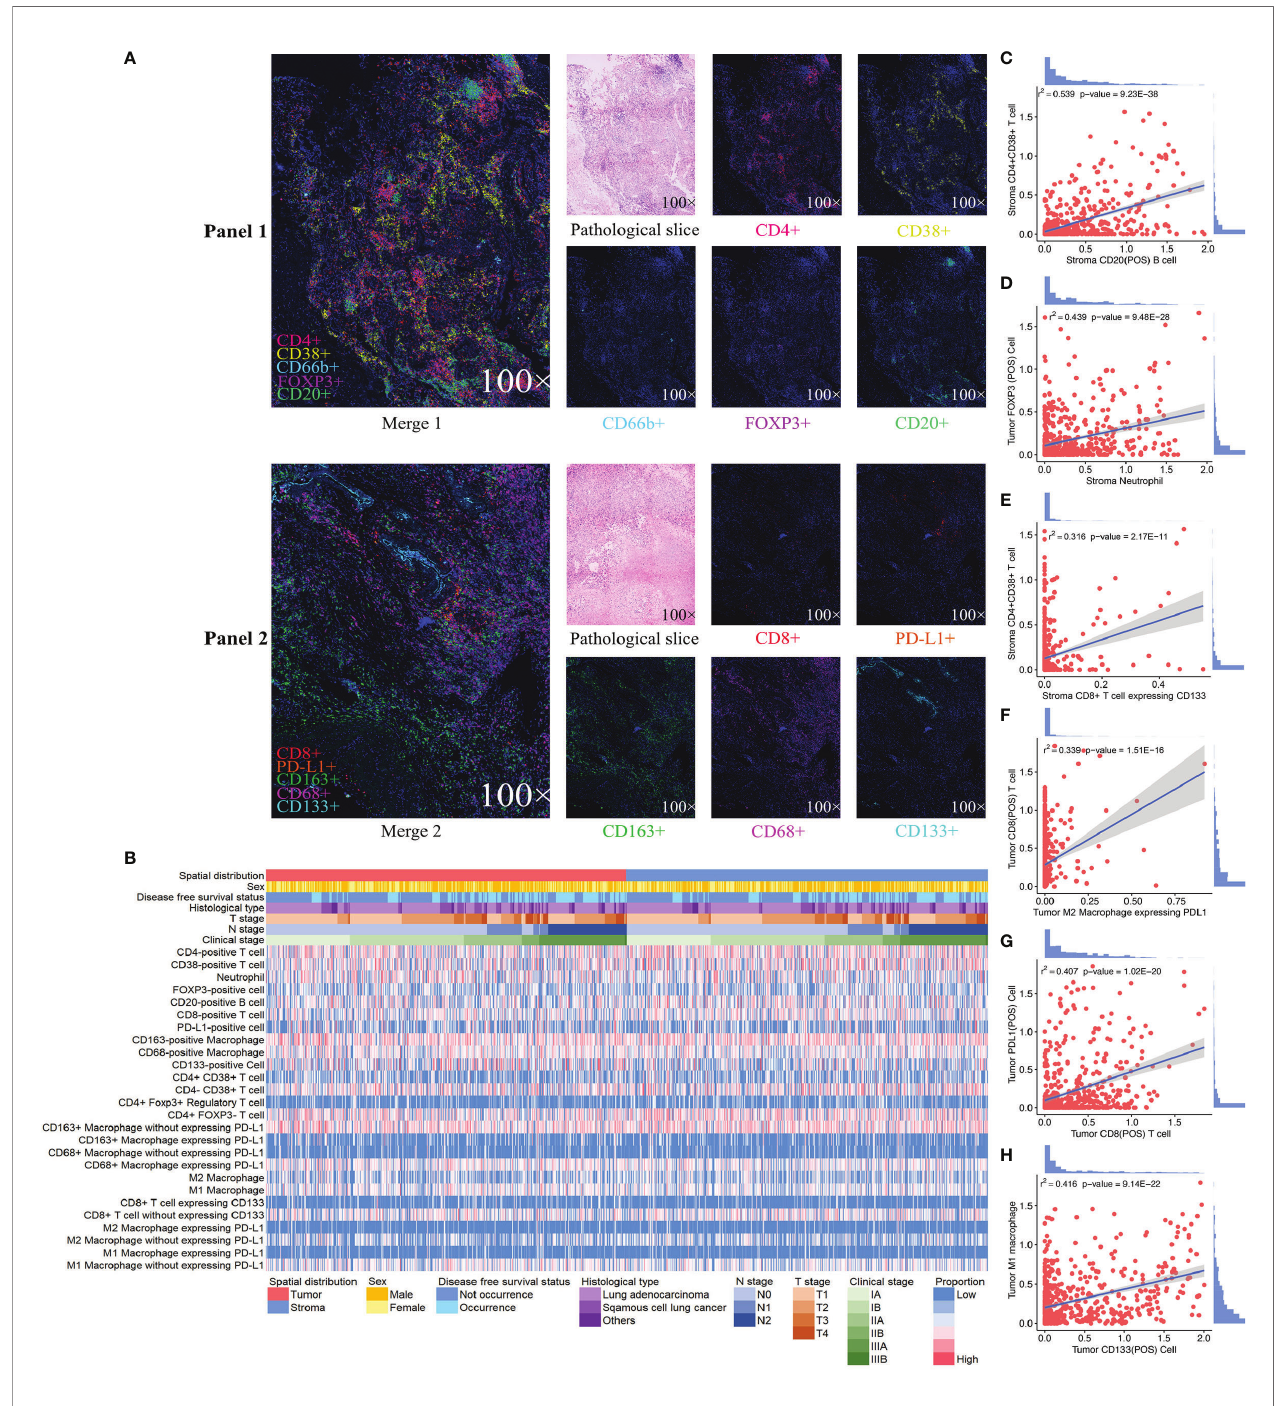
FIGURE 1 | Expression pro fi le of 10 immune biomarkers in non-small cell lung cancer. Single and merged immuno fl uorescence images and pathological slices are shown accordingly (A) . Immune landscape of the tumor immune microenvironment (TIME) illustrates the log percentage (lg%) of each type of immune cell within tumor nest and tumor stroma. Each value corresponds to the clinical characteristics of the patients, including sex, disease-free survival status, histological type, clinical stage, T stage, and N stage (B) . The dotted line graphs illustrate the correlations between immune cells in TIME, and the bar graph shows the distribution of the logarithmic percentage (lg%) of the proportion: (C) intrastromal CD20-positive B cells and intrastromal CD4+CD38+T cells, (D) intrastromal neutrophils and intratumoral FOXP3-positive cells, (E) intratumoral CD8-positive T cells and M2 macrophages expressing PD-L1, (F) intratumoral CD38-positive T cells and intratumoral CD20-positive B cells, (G) intratumoral CD8-positive T cells and intratumoral PD-L1-positive cells, and (H) intratumoral CD133-positive cells and intratumoral M1